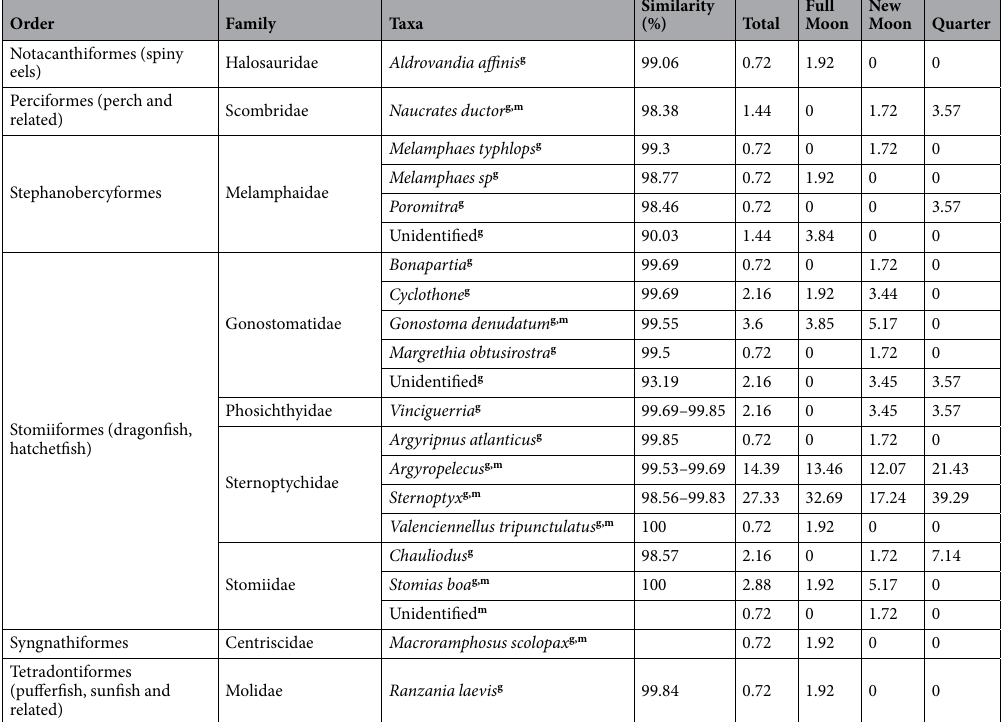
Table 1. Frequency of occurrences (%FO) of prey in the stomach-contents of chicks of Bulwer’s petrel. Taxa were identified to the lowest taxonomical rank using phylogenetic assignments of 16S rRNA barcodes (Fig. 1) and identification algorithms in BOLD-IDS for COI. Sequence similarity percentages using BOLD-IDS and BLAST are shown. The common names of representative taxa of each order are presented for teleosts. %FO, is expressed as the number of occurrences of a specific taxa divided by the total number of all stomach contents (Total) and by the total number of stomach contents collected in each lunar phase (Full Moon, New Moon, Quarter). Specimens that matched the same genera but formed distinct clusters on the tree were identified as distinct Operational Taxonomic Units (OTUs). g,m Represent, respectively, genetic and morphological based methods used to make a positive identification * Query sequences were identified as Architeuthis dux despite low bootstrap support due to the uniqueness of this taxon and completeness of the reference tree, with sequences clustering with no other